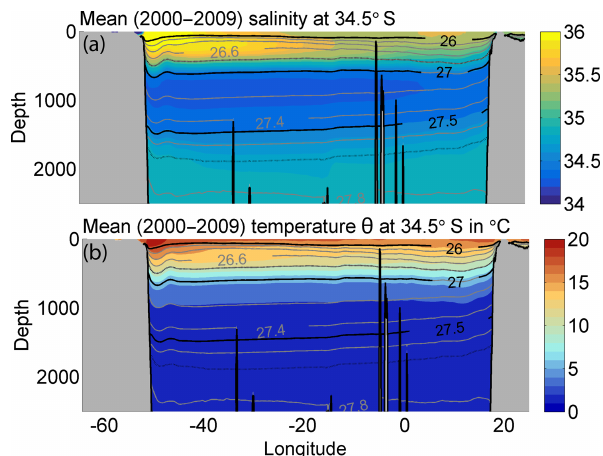
Figure 8. Mean (2000–2009) simulated Eulerian (a) salinity and (b) potential temperature θ sections at 34.5 ◦ S (color shading); po- tential density anomalies are overlaid in grey contours – those used as a separation of upper, intermediate, and deep waters are in